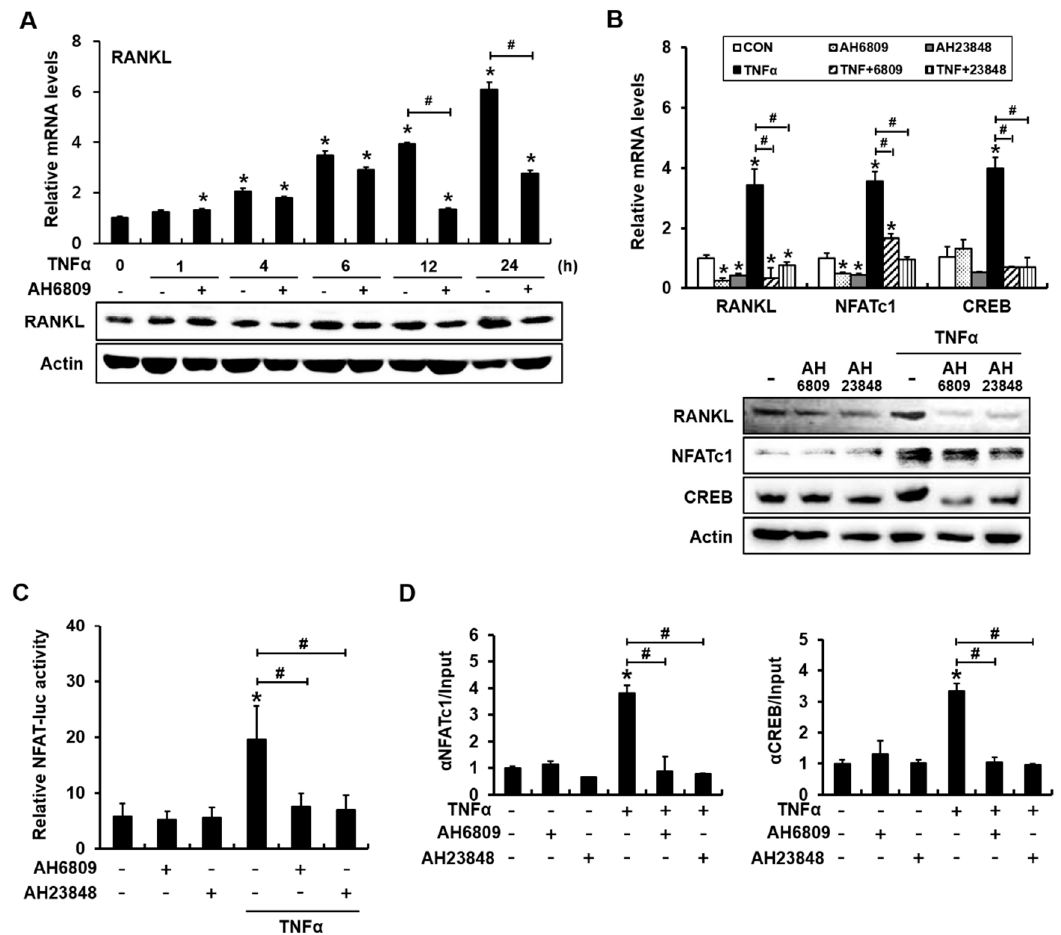
Figure 5. The PGE 2 receptor antagonists AH6809 and AH23848 suppress the TNF α -induced activation of NFAT and binding of NFATc1 and CREB to the RANKL promoter in C2C12 cells. ( A ) PGE 2 receptor antagonists significantly inhibited TNF α induction of RANKL only after incubation for 12 and 24 h; ( B ) AH6809 and AH23848 blocked TNF α -mediated RANKL , NFATc1, and CREB expression. AH6809 and AH23848 partially suppressed TNF α -induced NFATc1 protein expression. C2C12 cells were incubated with AH6809 (5 μ M) or AH23848 (5 μ M) in the presence or absence of TNF α for 24 h; ( C ) PGE 2 receptor antagonists abolished TNF α -induced NFAT transcriptional activity; ( D ) PGE 2 receptor antagonists prevented TNF α -induced NFAT and CREB binding to the mouse RANKL promoter (* p < 0.05, compared to control; # p < 0.05).